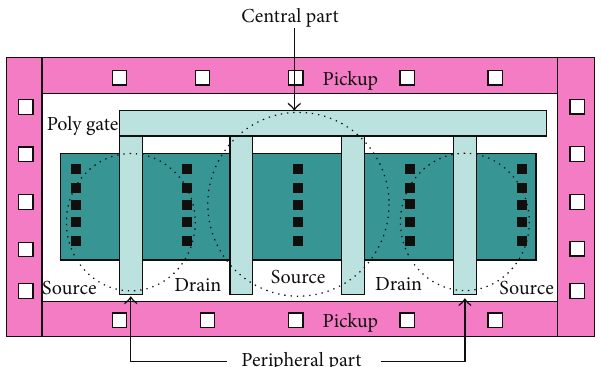
Figure 1: The layout top view of the gate-grounded multifinger ESD